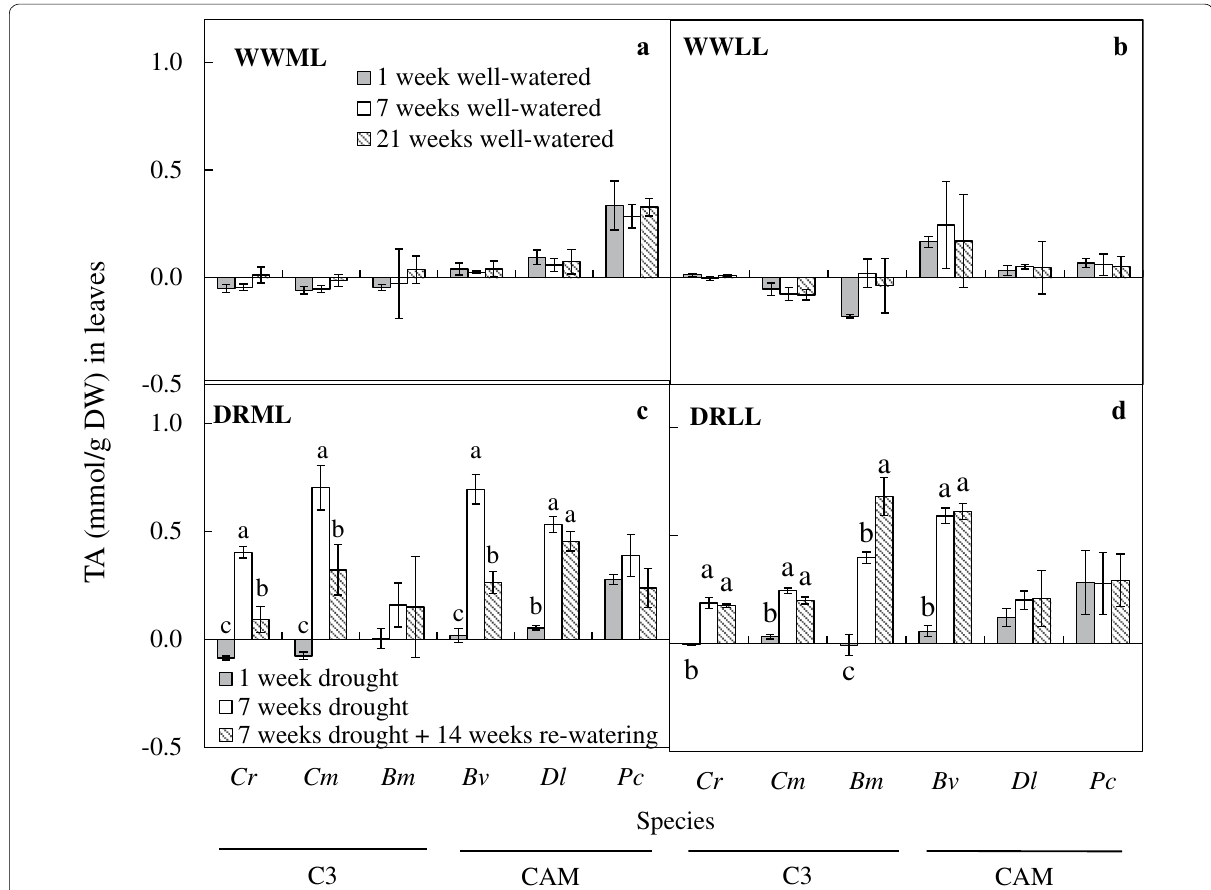
Fig. 8 Changes of TA in leaves of C. rochussenii ( Cr ), C. mayeriana ( Cm ), B. membranaceum ( Bm ), B. vaginatum ( Bv ), D. leonis ( Dl ) and P. cornu - cervi ( Pc ) after 1, 7 and 21 week(s) of well-watered condition under WWML ( a ), WWLL ( b ), and after 1 and 7 weeks of drought and after 14 weeks of re-watering under moderate light ( c ) and low light ( d ). Vertical error bars represent standard error. Different letters above bars indicate statistical difference (Tukey’s multiple comparison, p < 0.05, n =